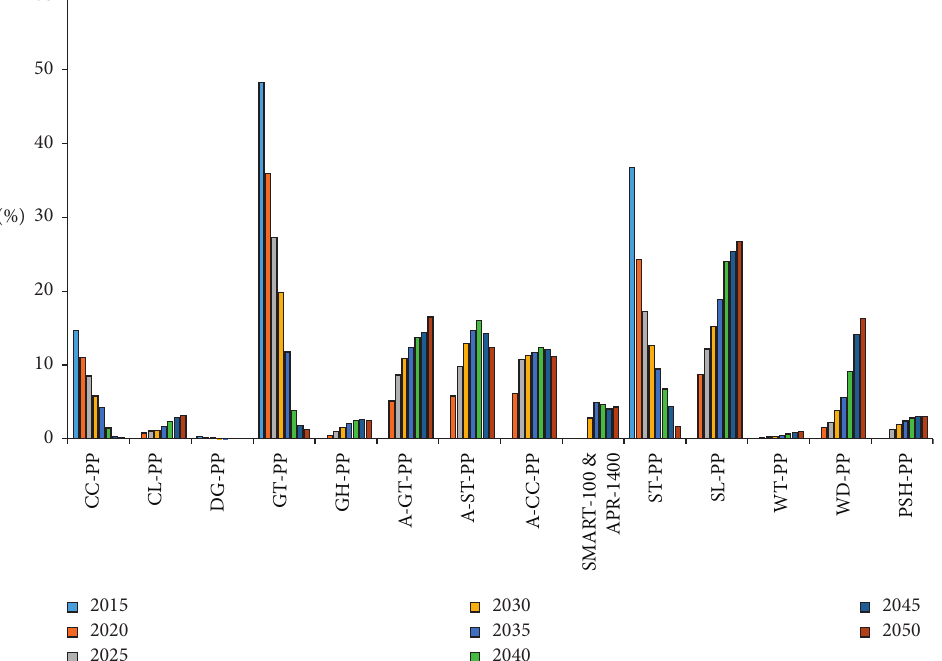
Figure 16: Share of power plant technologies for Subscenario III-3.